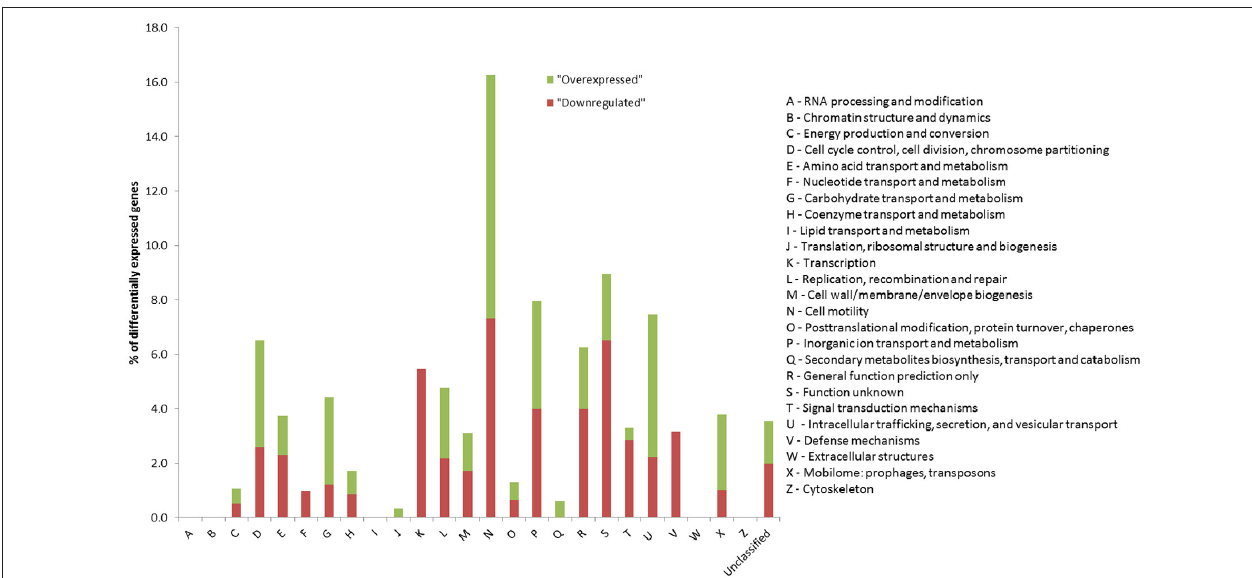
FIGURE 6 | Classification by COG (cluster of orthologous group) annotation of the 208 genes differentially expressed between P. luminescens overexpressing dam and the control strain. Results show the percentage of genes from each COG class differentially expressed between the P. luminescens dam -overexpressing strain and the control strain, according to the 2014 update (ftp://ftp.ncbi.nih.gov/pub/COG/COG2014/static/lists/homeCOGs.html).